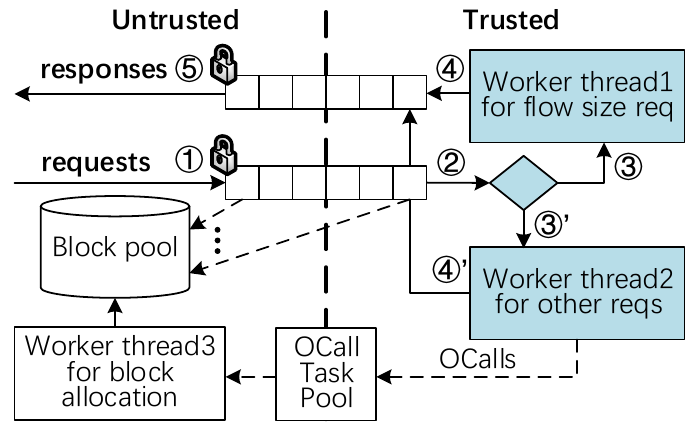
Figure 8. The architecture of a switchless request and